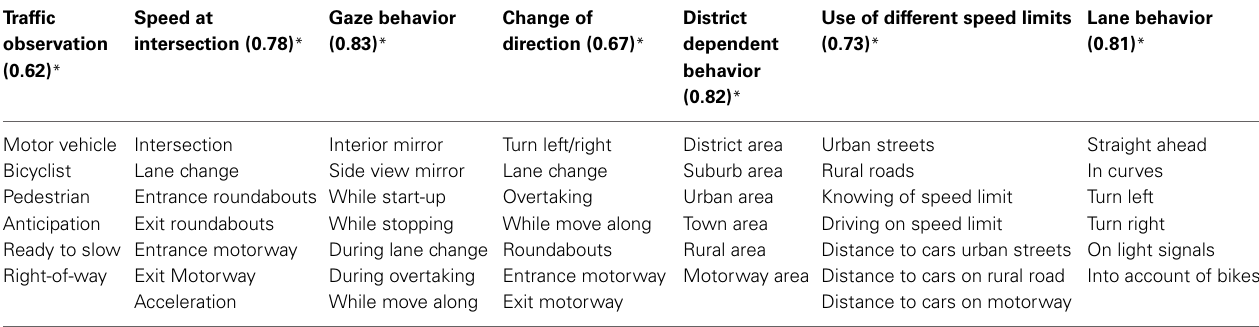
Table 2 | ZOA (Zurich On-road Assessment).